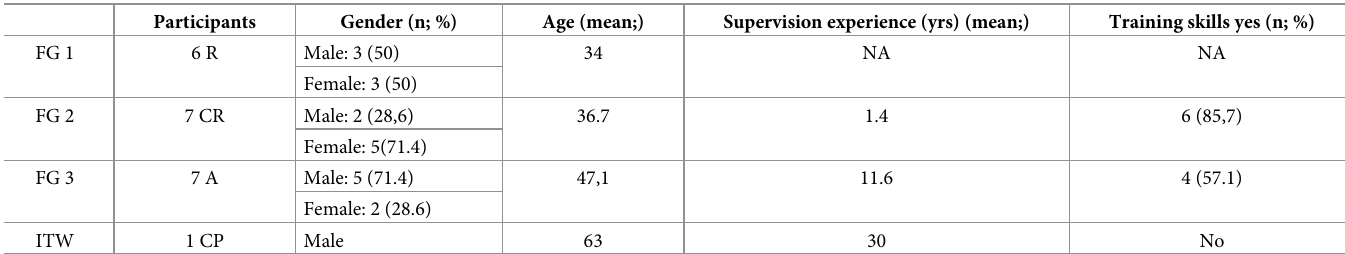
Table 1. Socio-demographic characteristics of the participants.